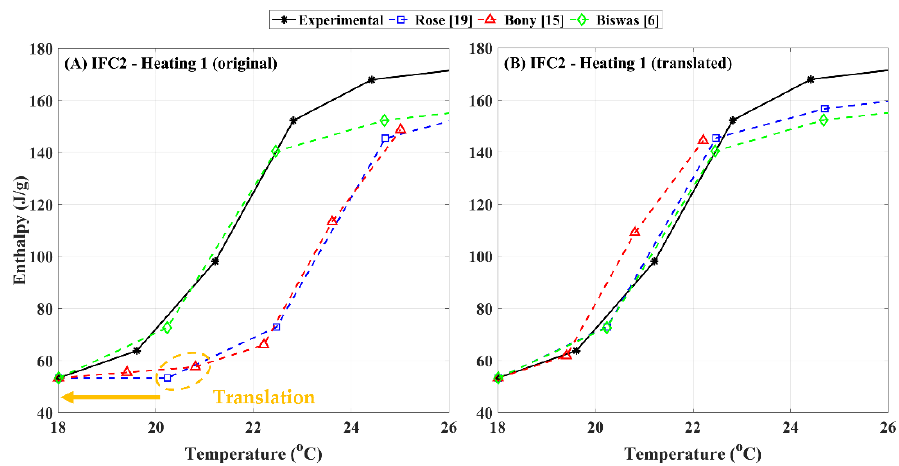
Figure 9. ( A ) Original and ( B ) translated heating curves during the interrupted cooling-heating test IFC2.